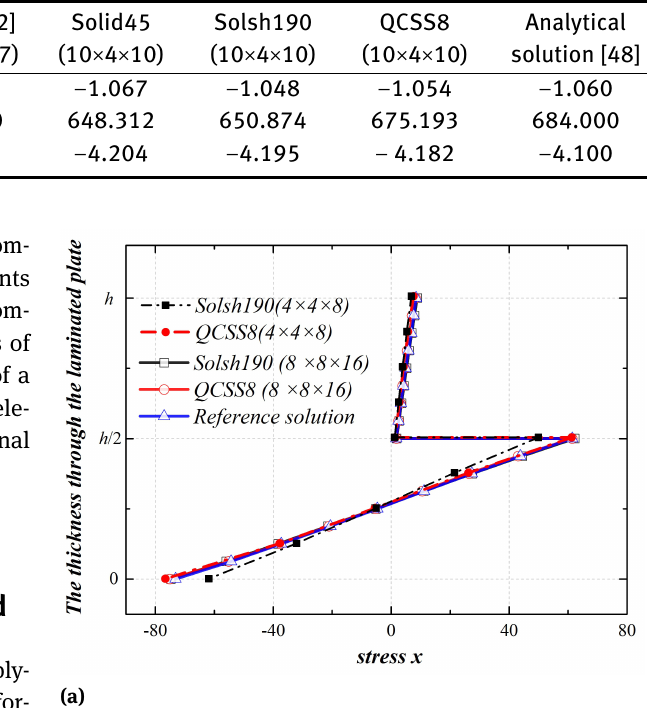
Table 3: The maximum displacements and the stresses on special point of a laminated strip.